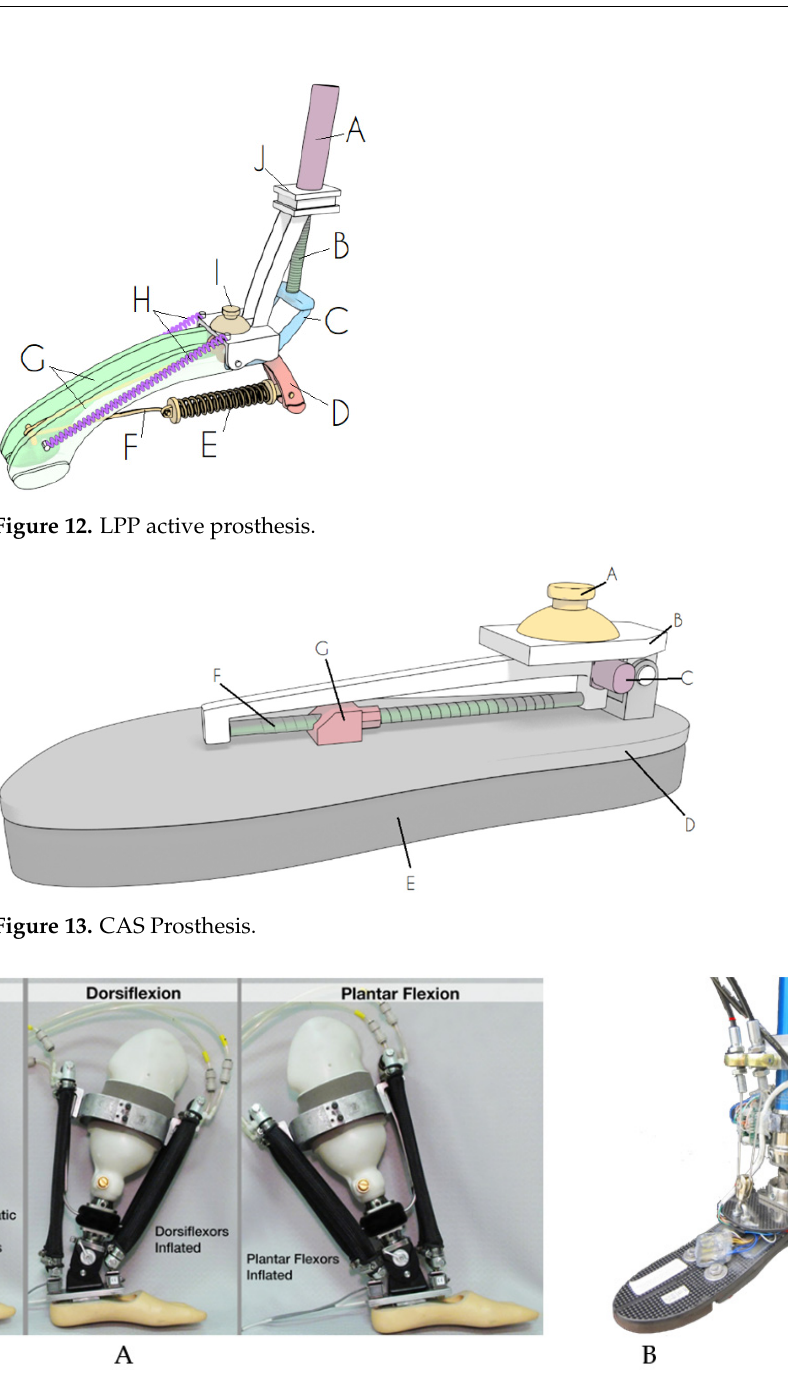
Figure 14. ( A ) Experimental powered lower limb prosthesis by Huang et al. [189] and ( B ) two DOF cable-driven ankle–foot prosthesis by Ficanha et al. [213].